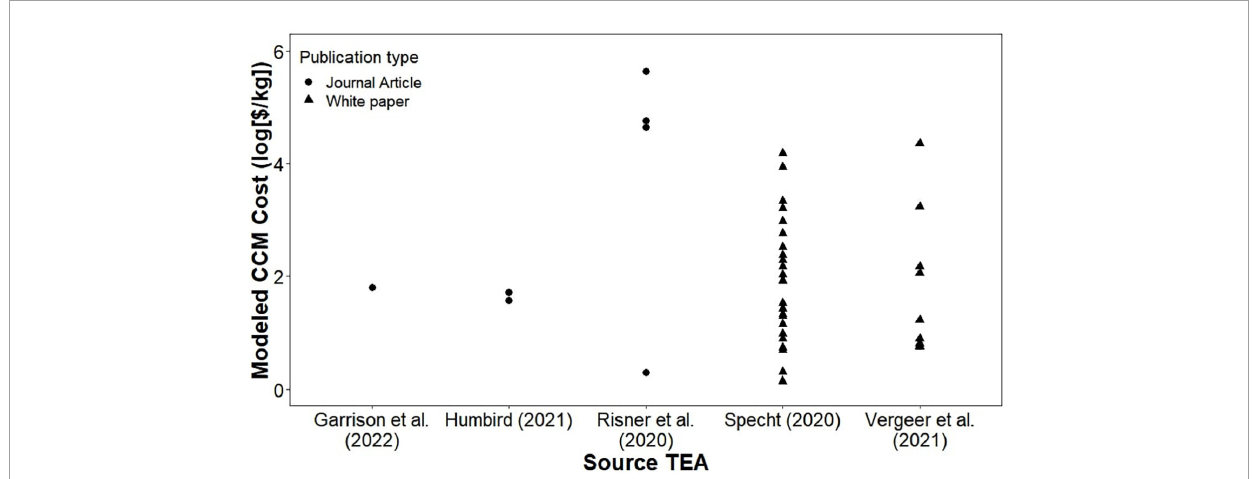
FIGURE1 The cost estimates from five published technoeconomic analyses, distinguished by publication in a refereed journal or as a white paper. Log scale used to capture range of values.